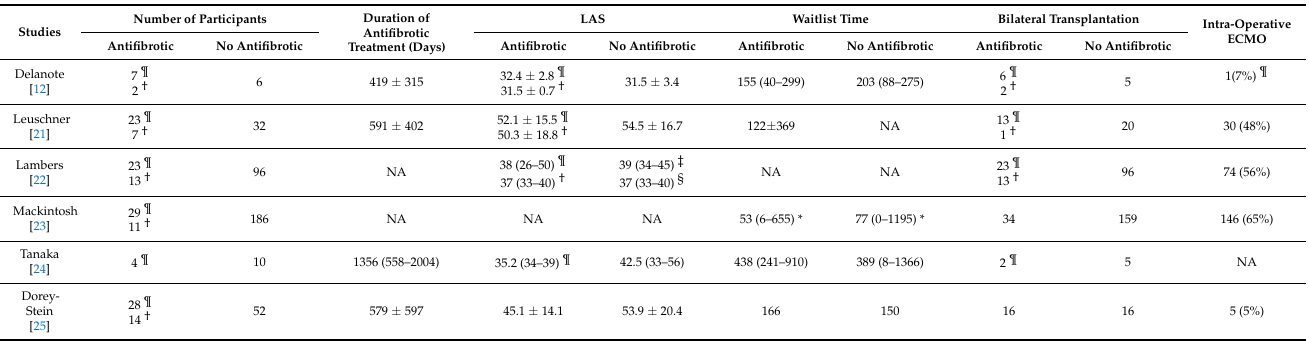
Table 1. Baseline characteristics of included